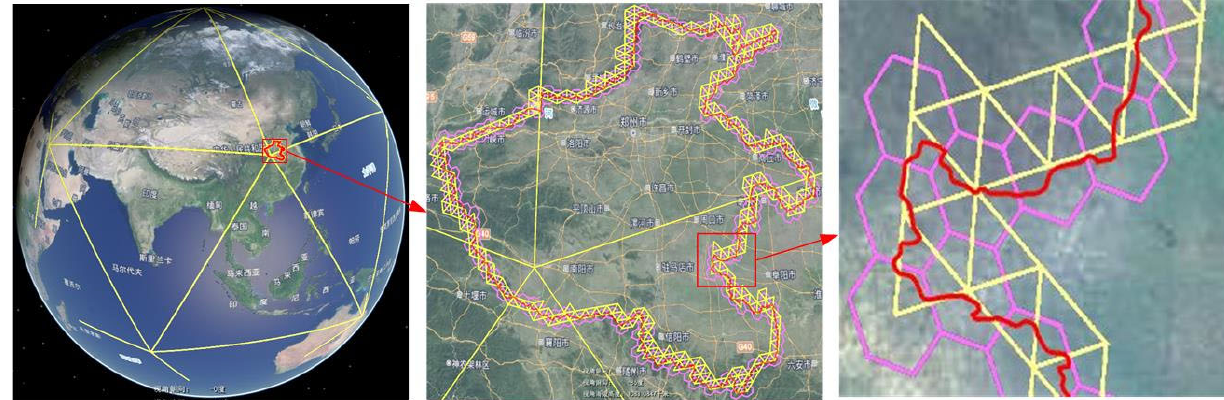
line and the basic data hexagon discrete line. Figure 13 is the superposition diagram of the ninth level TtoDcode diamond discrete line and the basic data triangle discrete line. It can be seen that there are certain deviations in the discrete lines expressed in different grids. It can be seen from Tables 18 and 19 that the maximum deviation value is less than the average diameter of the grid cells at corresponding levels. In practical application, the appropriate hierarchical grid can be selected for conversion according to the accuracy requirements.